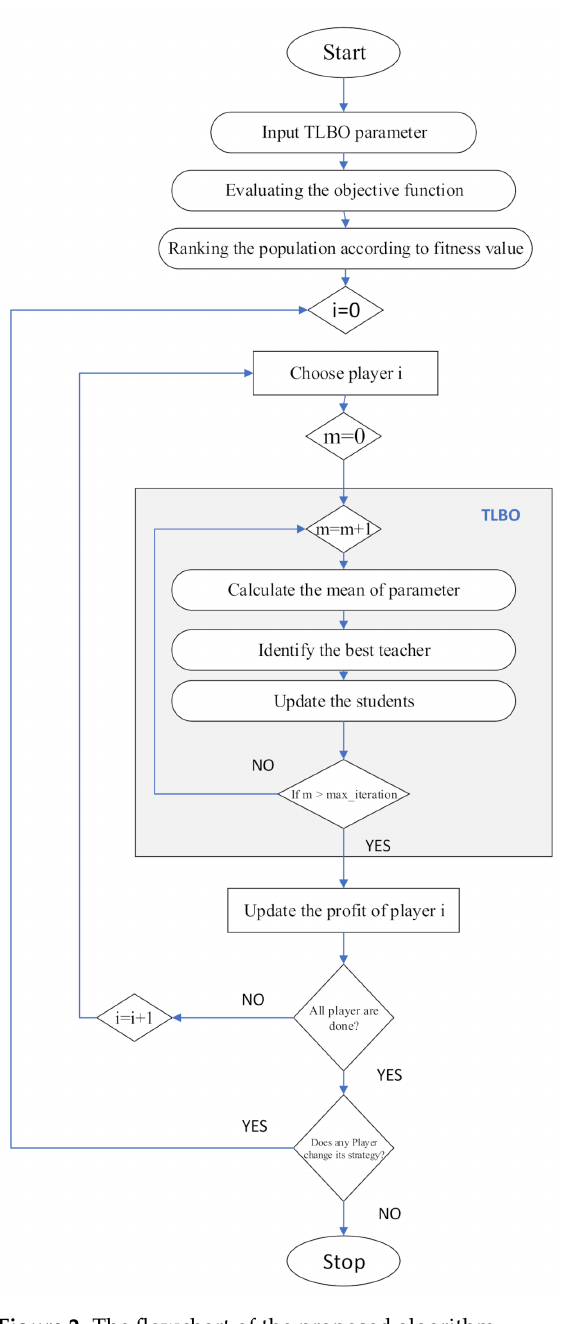
Figure 2. The flowchart of the proposed algorithm. Table 3. Parameters of the TLBO